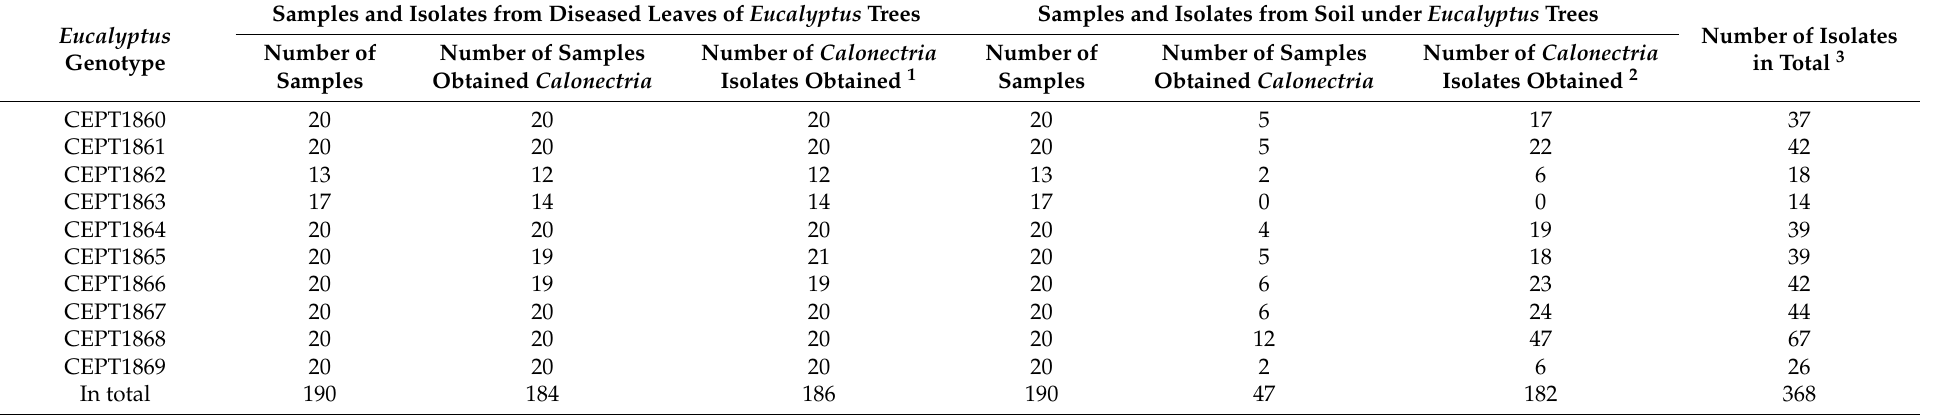
Table 2. Samples and isolates of Calonectria obtained from ten Eucalyptus genotypes in this